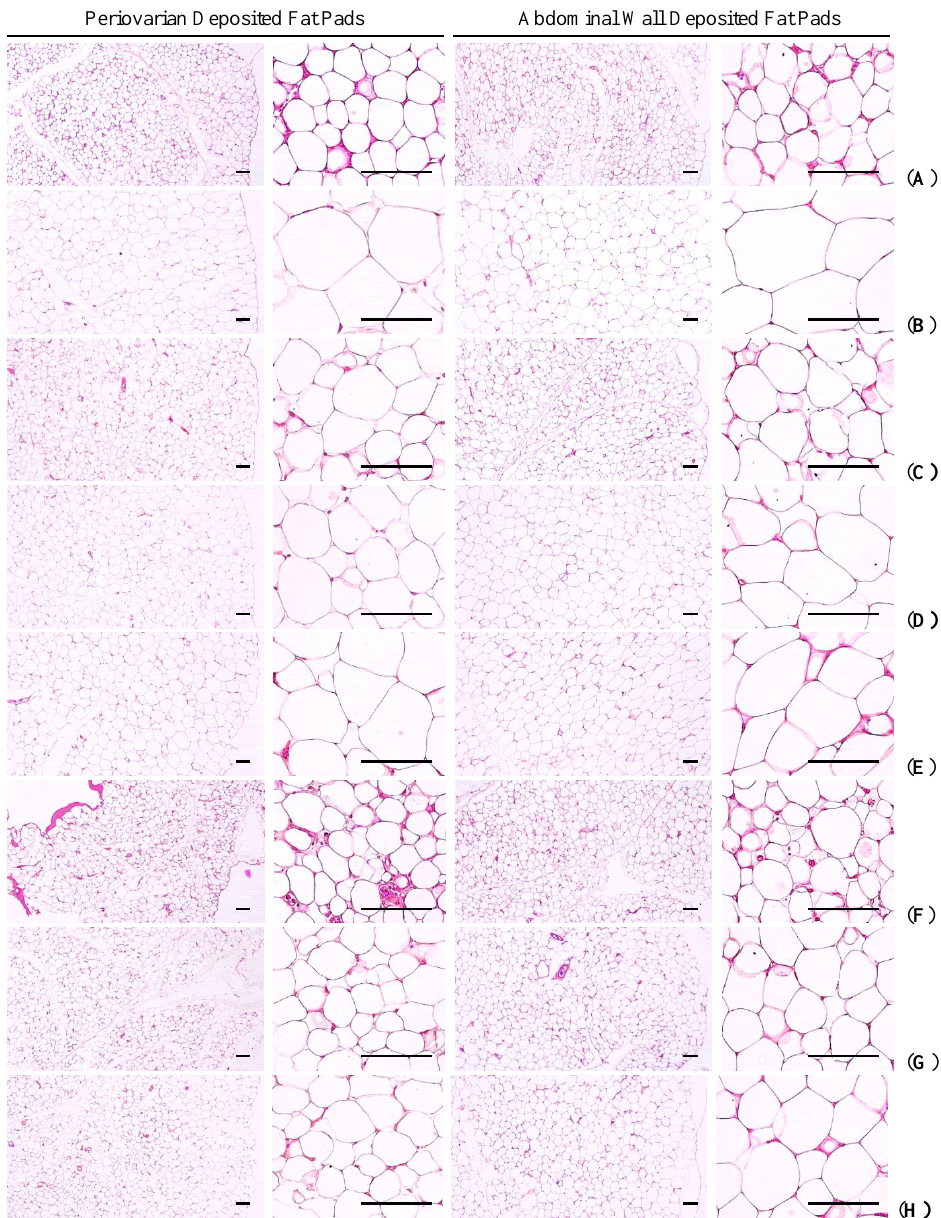
Figure 3. Representative histological images of the adipocytes, taken from NFD or HFD supplied mice periovarian and abdominal wall deposited fat pads. ( A ) Intact control: Normal pellet diet supplied vehicle control mice; 10 mL/kg of distilled water oral administered mice; ( B ) HFD (vehicle) control: 10 mL/kg of distilled water oral administered mice with HFD supply; ( C ) Simvastatin: 10 mg/kg of simvastatin oral administered mice with HFD supply; ( D ) Metformin: 250 mg/kg of metformin oral administered mice with HFD supply; ( E ) GT400: 400 mg/kg of GT oral administered mice with HFD supply; ( F ) fGT400: 400 mg/kg of fGT oral administered mice with HFD supply; ( G ) fGT200: 200 mg/kg of fGT oral administered mice with HFD supply; ( H ) fGT100: 100 mg/kg of fGT oral administered mice with HFD supply. NFD, normal fat pellet diet; HFD, high fat diet; GT, green tea extracts; fGT, Aquilariae lignum -fermented green tea extracts. All Hematoxylin & Eosin stain. Scale bars = 80 µm.